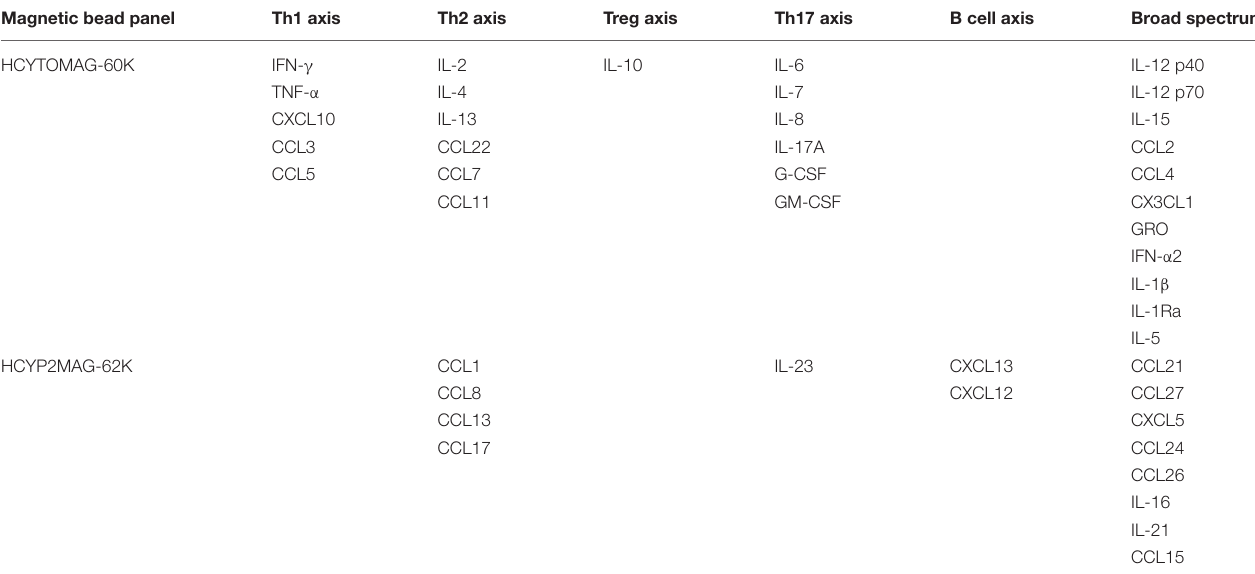
TABLE 1 | Cytokines/chemokines detected in the study. Magnetic bead